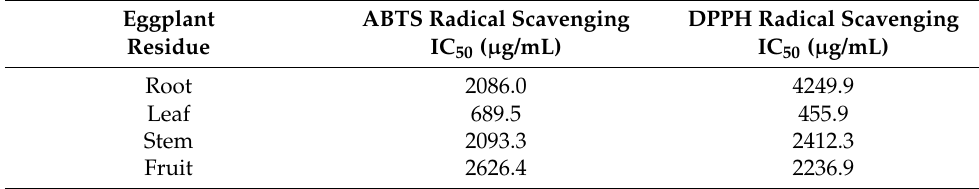
Table 3. Antioxidant capacity of eggplant